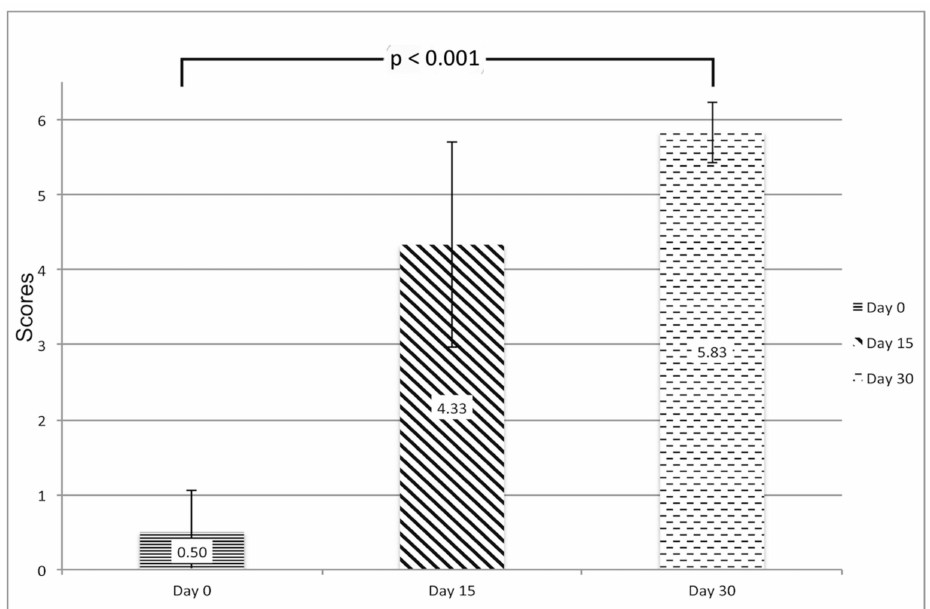
Figure 2. Semiquantitative assessment of the degree of ischemia in response to painful stimuli. The graphic represents the degree of perception of painful stimuli at the hind ischemic limb on day 0, day 15 and day 30 (group A). A recovery of nociceptive sensitivity has been observed (0.5 ± 0.55 on day 0 vs. 5.83 ± 0.41 on day 30). Data shown as mean ± standard deviation